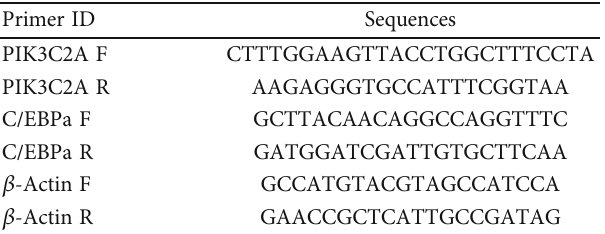
Table 1: The sequences of primers for PIK3C2A, C/EBPa, and β -